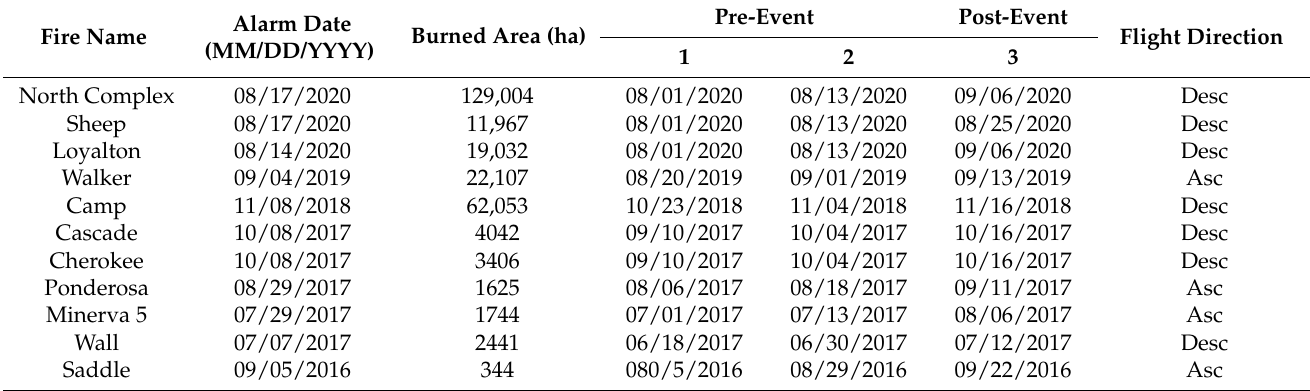
Table 2. Wildfire information and Sentinel-1 SAR data used in this study.